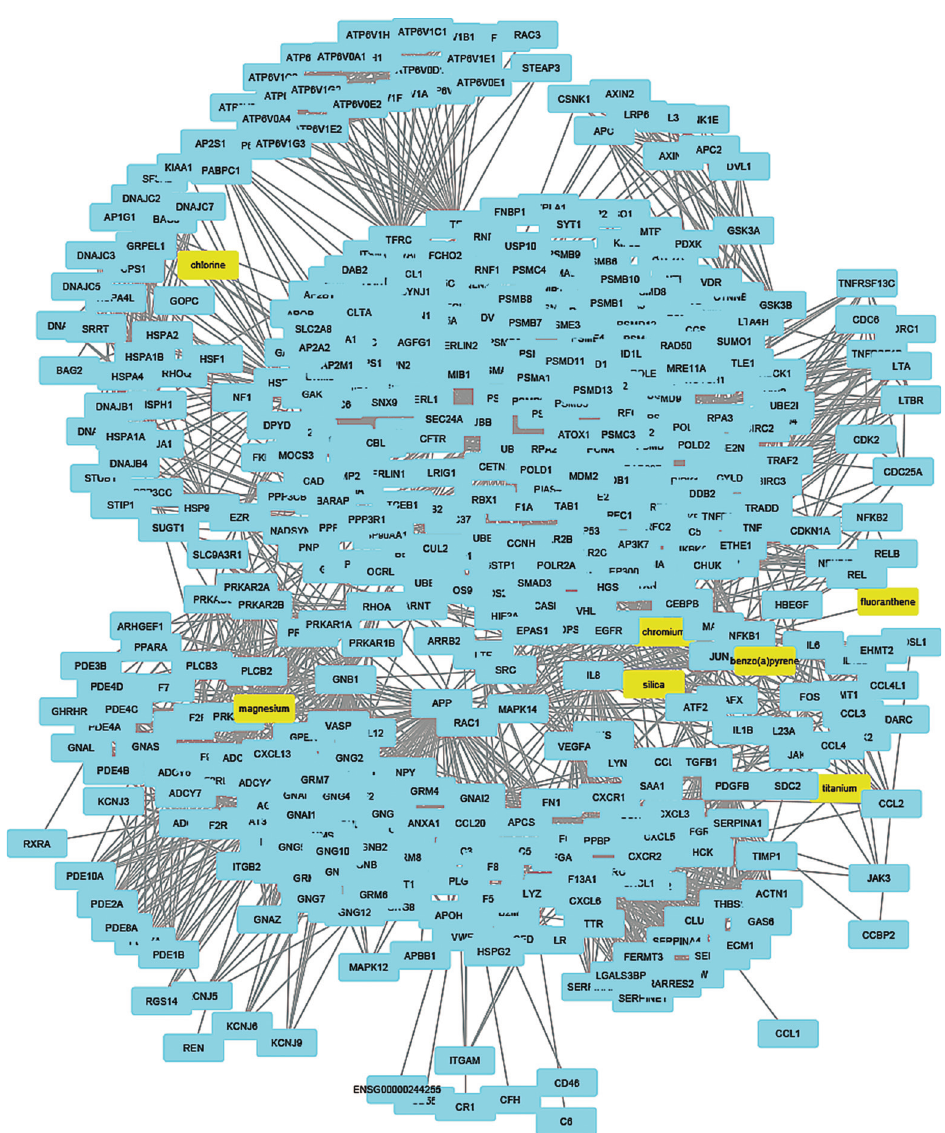
Figure 2 - Cluster analysis of the major CPI-PPI network showing the association of cluster 6 with MIOs, IEs, and PAHs (yellow). The cluster is composed of 487 nodes and 5,545 edges, with Ci = 22,725. The associated constituents are SiO 2 , Ti, Mg, Cr, Cl, fluoranthene, and